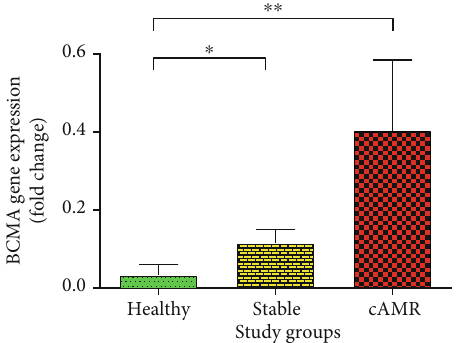
Figure 7: mRNA expression level of BCMA in healthy individuals, patients with stable graft function, and cAMR patients. Error bars represent SEM ( ∗ P ≤ 0 : 05 , ∗∗ P ≤ 0 : 01 ).